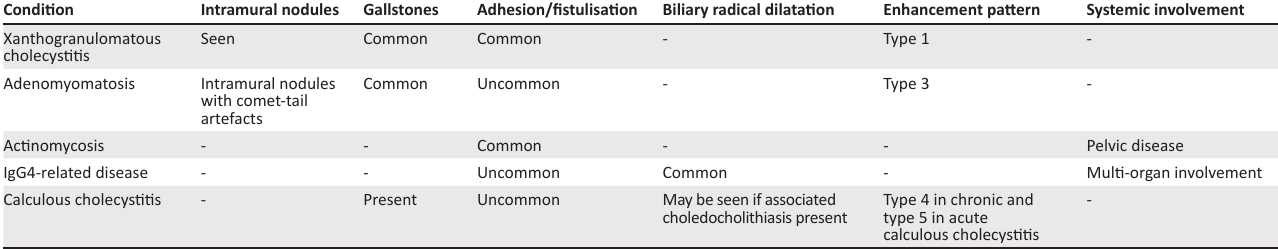
TABLE 2: Comparison of imaging features in inflammatory causes of gallbladder wall thickening. Condition